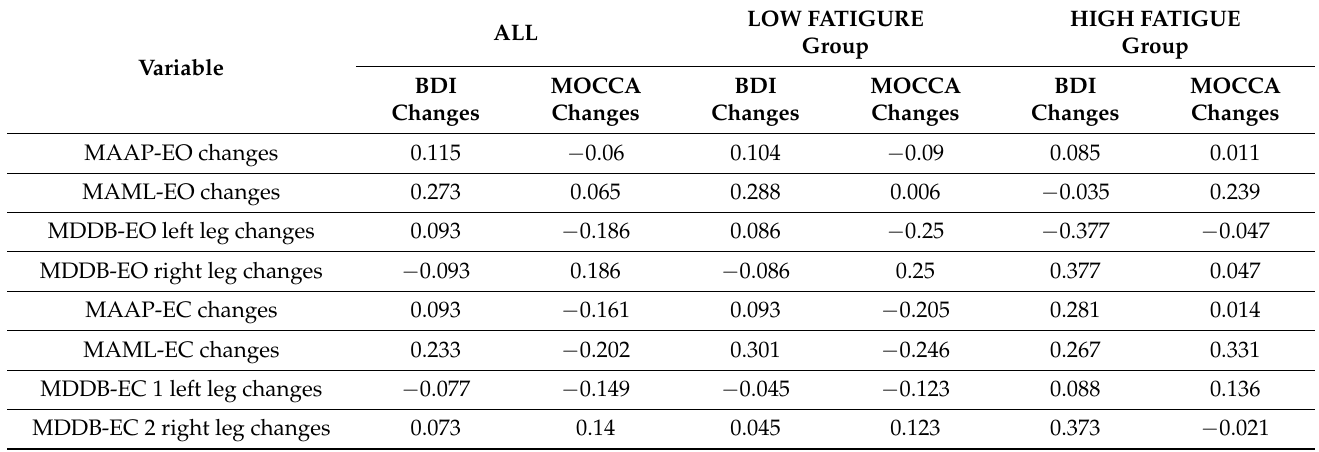
Table 4. Correlations between results of stabilometric platform, MOCCA, and BDI test results among MS patients under the age of 65 with low and high fatigue.